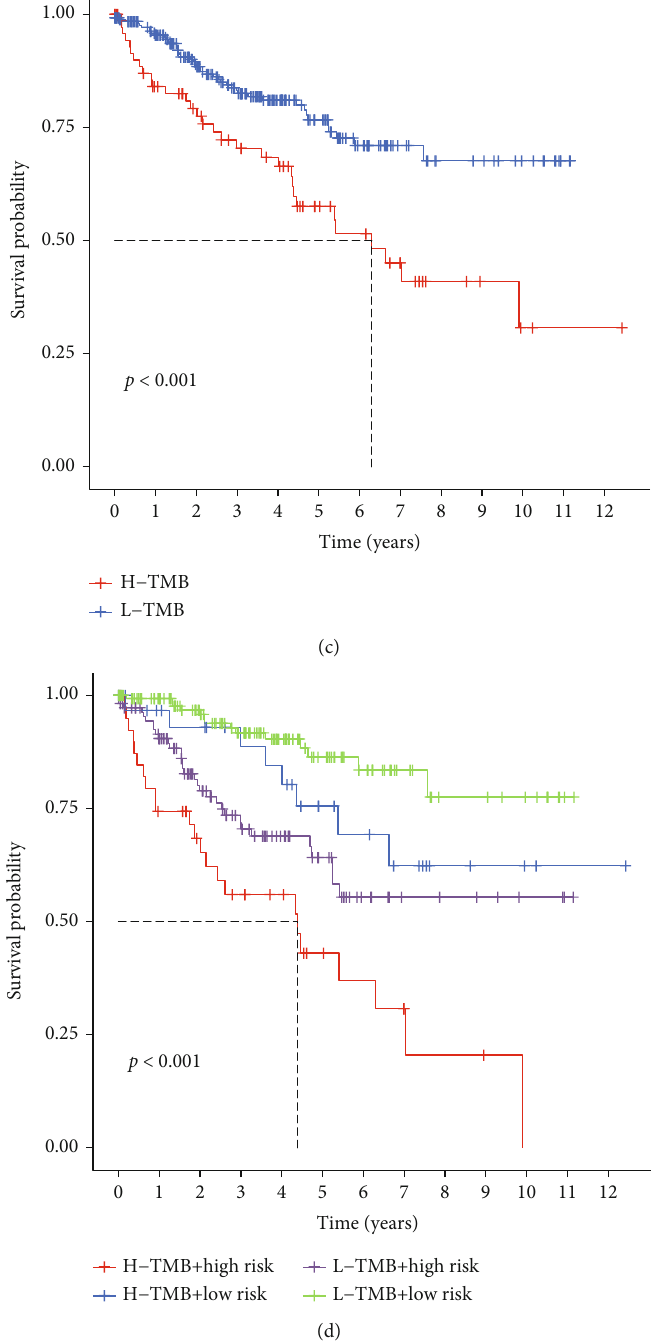
Figure 6: The correlations between IGRPM-based risk characteristic and immune cells in fi ltration and TMB. (a) Heat map showing correlation of 17 genes used to construct IGRPM with 22 kinds of human immune cells. (b) Comparison of TMB between the low-risk and high-risk groups in TCGA-KIRC cohort. (c) Kaplan-Meier survival analysis based on the TMB in the TCGA-KIRC cohort. (d) Combining with the risk characteristic based on IGRPM and the TMB in the TCGA-KIRC cohort, the survival analysis of the four groups strati fi ed was carried